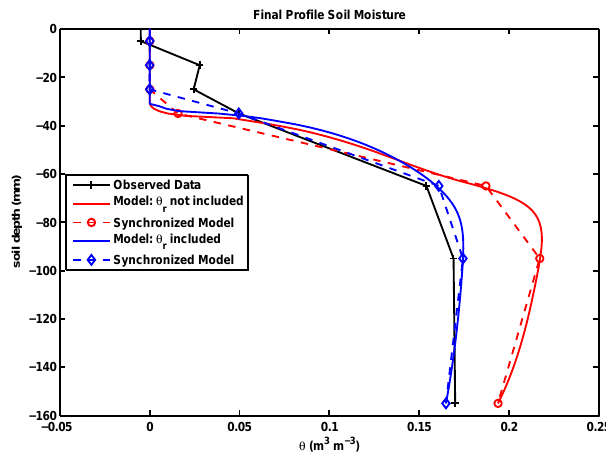
Figure 15. Comparison of the final modeled and measured moisture profiles at the completion of the 70min Palousse B Wet heating ex- periment. Because the data shown in the measured profile (black) are not precisely coincident in time, the full model results (solid red and blue lines) were sub-sampled in synchrony in time (and coincide in space) with the observations. These time-synchronized model profiles are shown as dashed red and blue lines. The observed data (black) suggest that the total water lost during the 70min ex- periment was 28.8% of the initial amount. The (red) model simu- lation indicated a 14.7% loss and the corresponding (red) synchro- nized model yielded a 15.8% loss. The (blue) model simulation indicated a 27.8% loss and the corresponding (blue) synchronized model yielded a 29.4% loss. Note there is very little recondensing soil moisture ahead of the drying front (at about 35mm depth), in agreement with Figs. 11 and